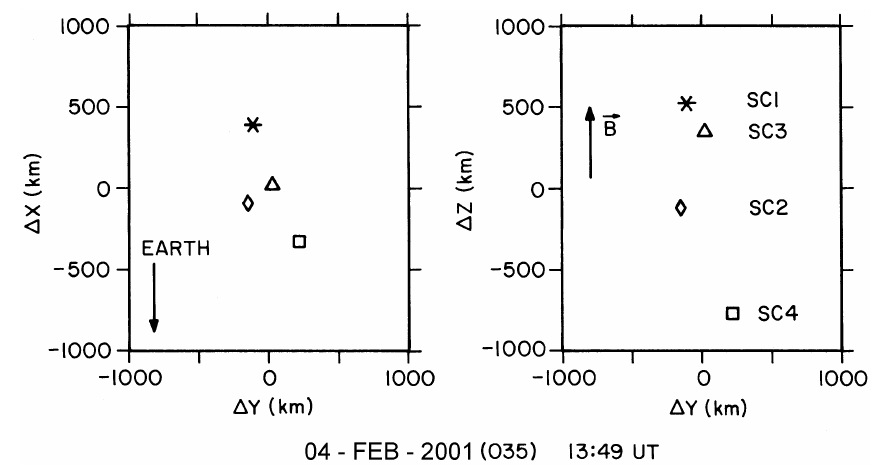
Careful measurements of the arrival times in Fig. 2